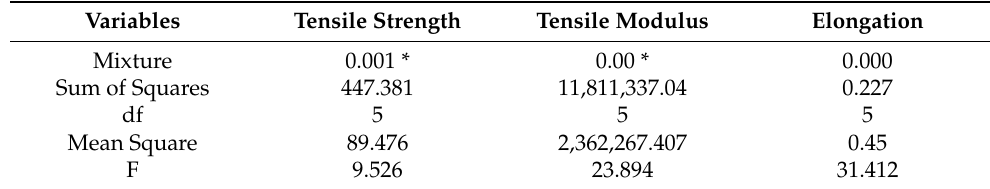
Table 1. ANOVA of tensile